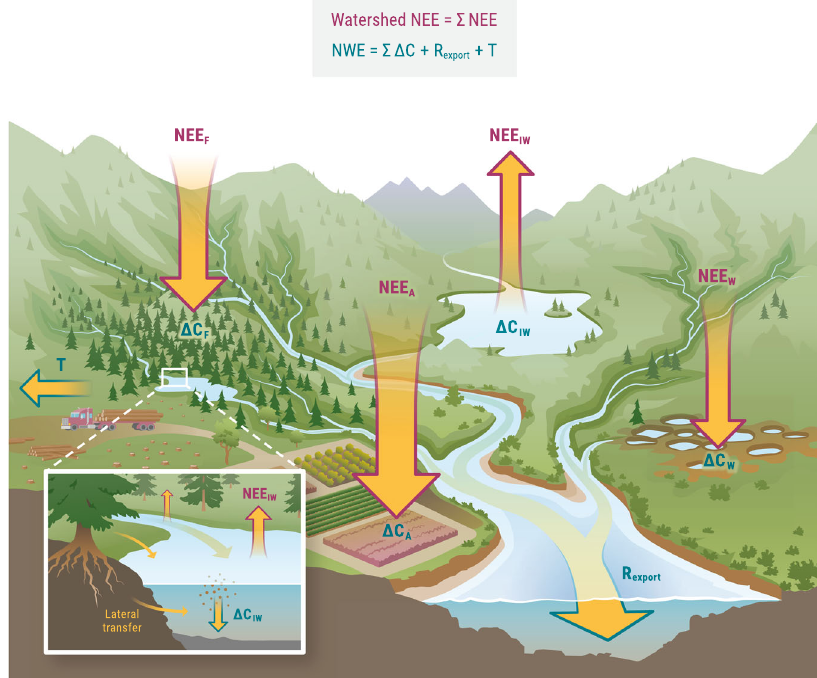
Fig. 1 | Carbon fl uxes across the atmosphere-land-water continuum of a watershed. Conceptual diagram of the vertical and lateral fl ows of biospheric carbon across a watershed, depicting the most common source/sink role of dif- ferent terrestrial and aquatic ecosystems. Highlighted in color are the elements involved in the calculation of land-atmosphere carbon exchange either as Water- shed NEE ( ∑ NEE ; in purple) or NWE (Eq. 3; in dark turquoise). Carbon is withdrawn from the atmosphere throughthephotosynthesis offorests, wetlands, agricultural lands, and other terrestrial ecosystems. Yet not all the carbon accumulates or returns to the atmosphere in situ. A signi fi cant fraction of terrestrial productivity and respiratory CO 2 is hydrologically transferred to inland waters, from where it can be emitted back to the atmosphere, stored in aquatic sediments, or routed downstream towards the watershed outlet (inset). Since inland waters receive